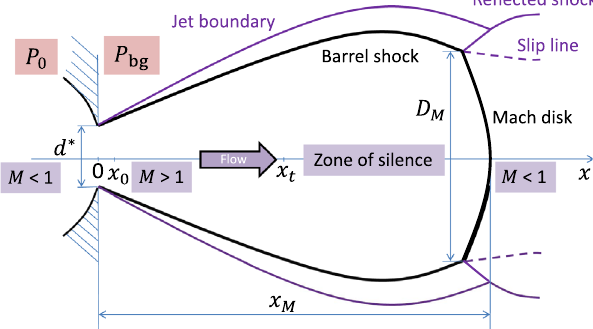
FIG. 6. Structure details of an axisymmetric (with revolution symmetry around the x axis) supersonic free jet. The nozzle exit is located at x ¼ 0 . The nozzle exit diameter d (cid:2) , the coordinate x D M , and diameter M of the Mach disk are